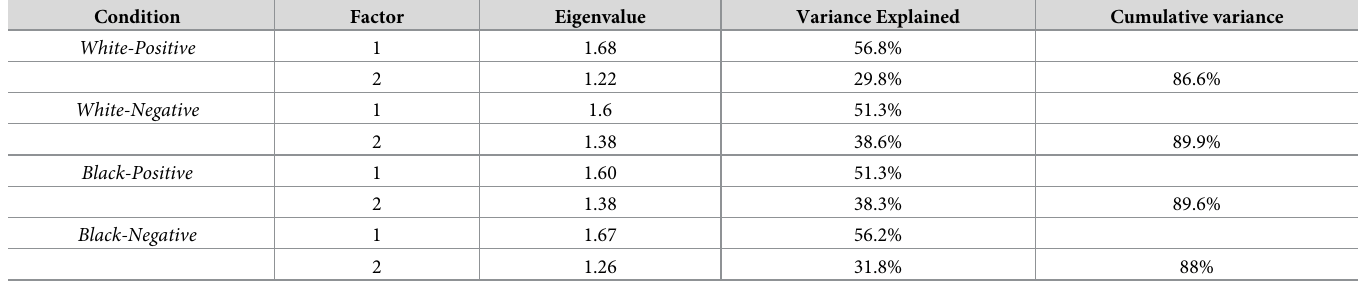
As reported in Table 3, two factors were isolated in all conditions, explaining a high per- centage of variance (min. = 86.6%–max. 89.9%). Based on the recurrent factorial structure extracted by the 4 PCAs (see Table 4), we attrib- uted the first factor a temporal dimension, while the second component was more related to kinematic measures and thus represented a ‘geometrical component’. As supported by Tucker’s Phi values, the factors isolated were consistent between-condi- tions (minimum value of congruence = -0.77, see Table 5). Considering the above findings and the information extracted by the factorial structure in each condition, we have considered as ‘target observed variables’ (i.e., the most representative variables of each factor) those that showed the highest saturation scores in most of the condi- tions (see Table 4). Accordingly, in our further analyses, the MD variable has been considered for the geometrical component and the Acc-Max-Time variable for the temporal dimension.